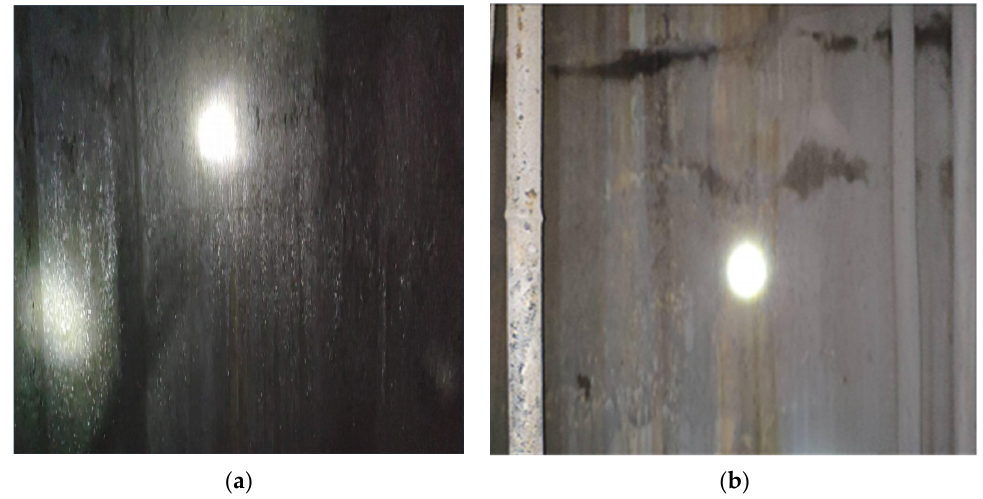
Figure 13. Comparison of water inflow at 146 m of the shaft before and after construction: ( a ) before construction; ( b ) after construction.